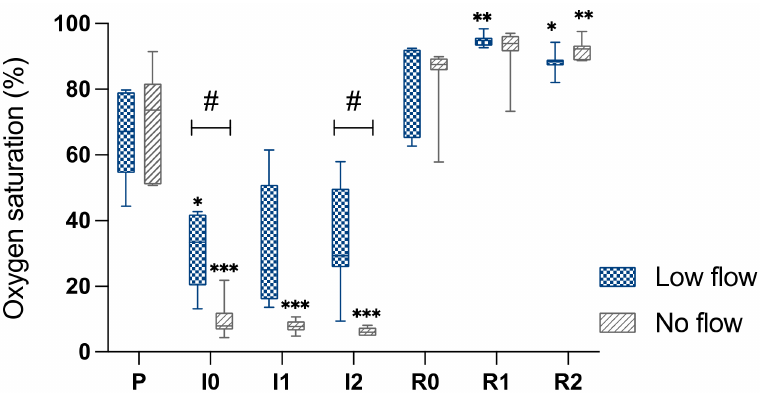
Figure 4. Box-plot diagram of the intestinal StO 2 by MS in% during the different time points. P, pre- ischaemia; I0, immediately after induction of ischaemia; I1, 60 min ischaemia; I2, 120 min ischaemia; R0, immediately following reperfusion; R1, 60 min reperfusion; R2, 120 min reperfusion. Significant differences of the time points compared to pre-ischaemia are marked with an asterisk (* p < 0.05; ** p < 0.01; p *** < 0.001), significant differences between the groups are indicated with a horizontal bar and accompanying hash (# p < 0.05).